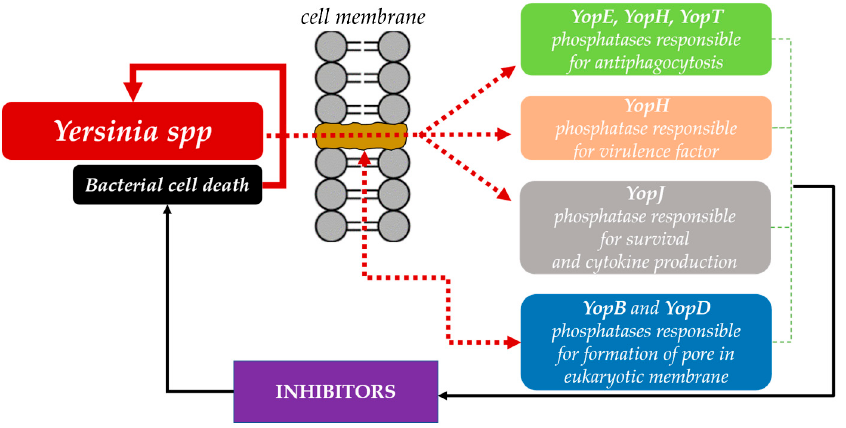
Figure 1. Phosphatases as virulence factors of Yersinia spp. The secretion model for translocation leads to secretion of virulence factors, among oth- ers YopH protein tyrosine phosphatase, which is involved in the inhibition of phagocytosis used by macrophages to get rid of pathogens